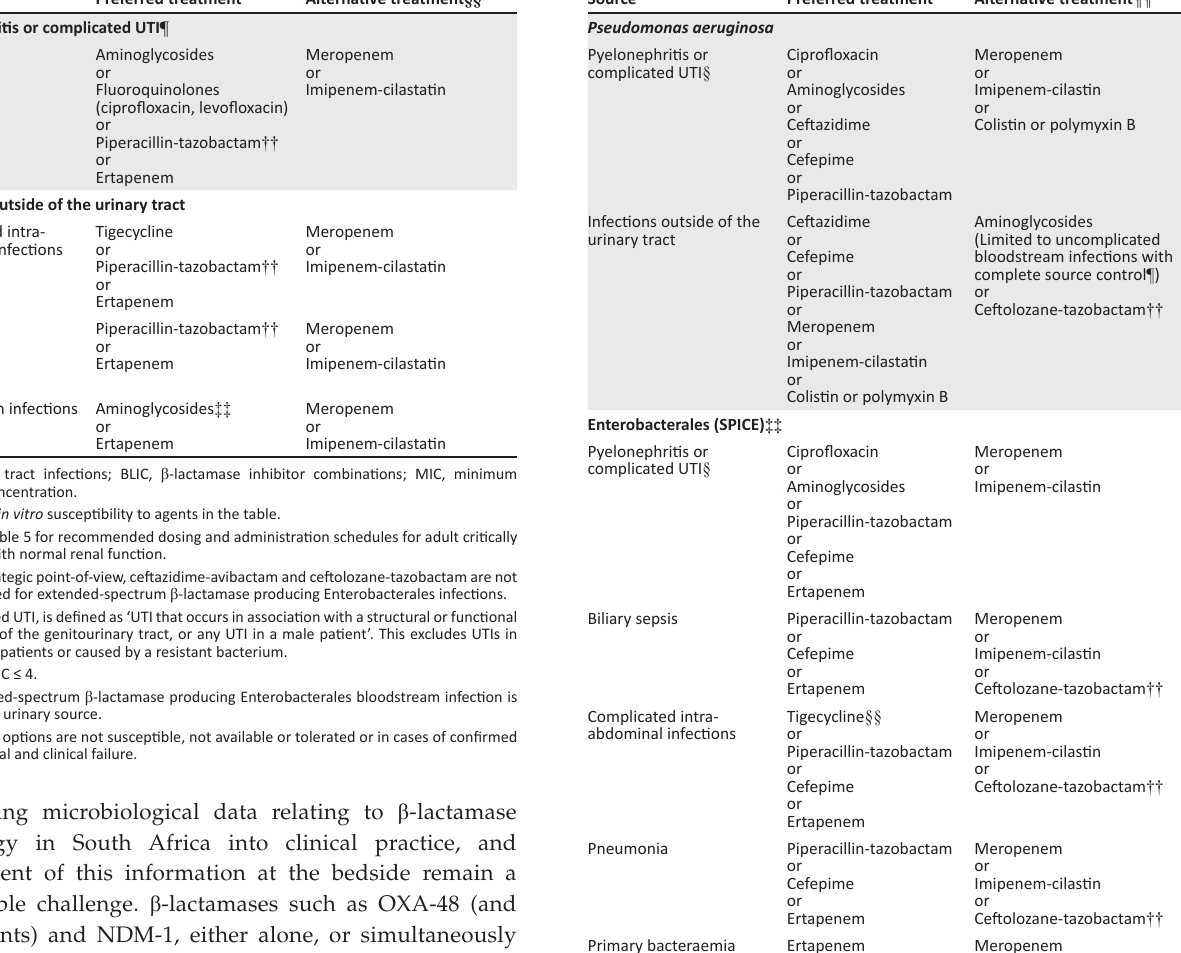
TABLE 2: Recommended intravenous antibiotic treatment options for extended- spectrum β -lactamase producing Enterobacterales. † , ‡ , § Source Preferred